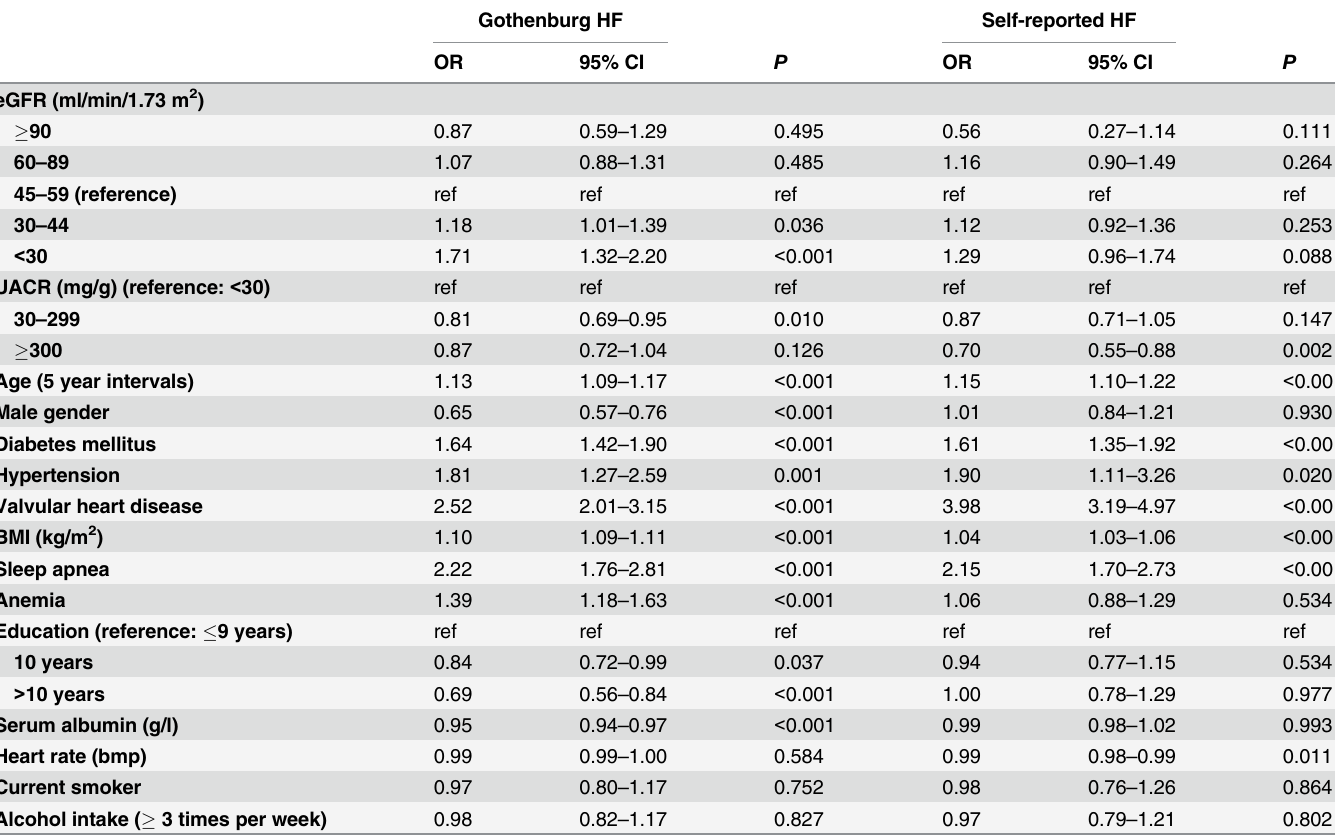
Table 5. Multivariable adjusted analyses of factors associated with Gothenburg HF and self-reported HF (n = 4,604) Gothenburg HF Self-reported